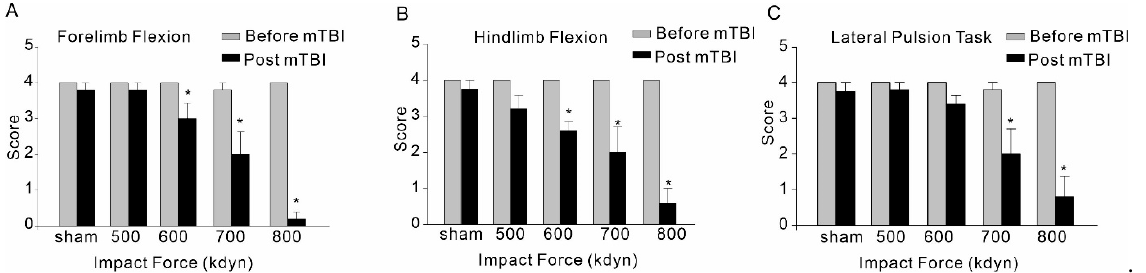
Figure 4. Effect of mTBI caused by gradient impact force on composite neuroscore behavioral, including forelimb flexion ( A ), hindlimb flexion ( B ) and lateral pulsion task ( C ), in C57/BL6 mice. Testing was completed within 2 h after TBIs. The dead mice scored zero. Data are mean ± SEM. * p < 0.05 compared to sham.